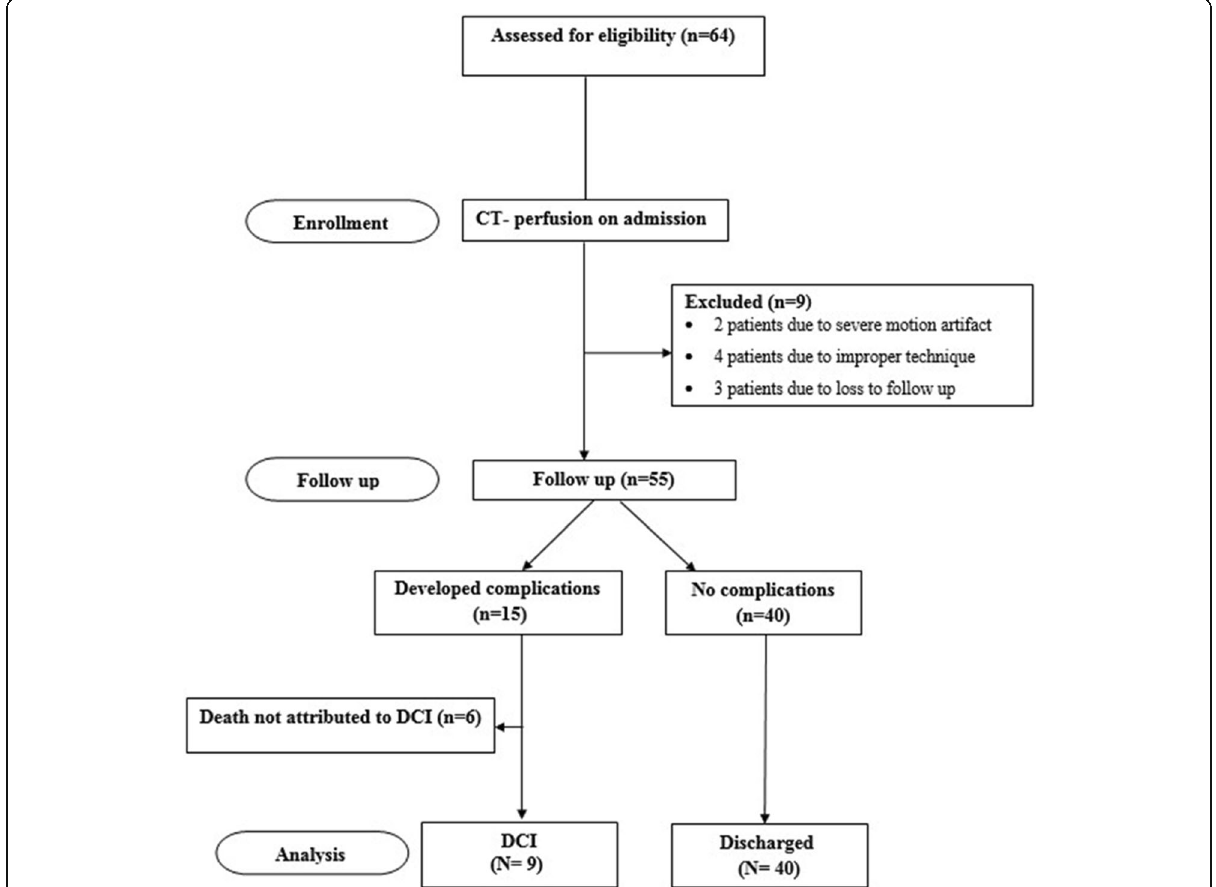
Fig. 1 Study flow chart. DCI , delayed cerebral